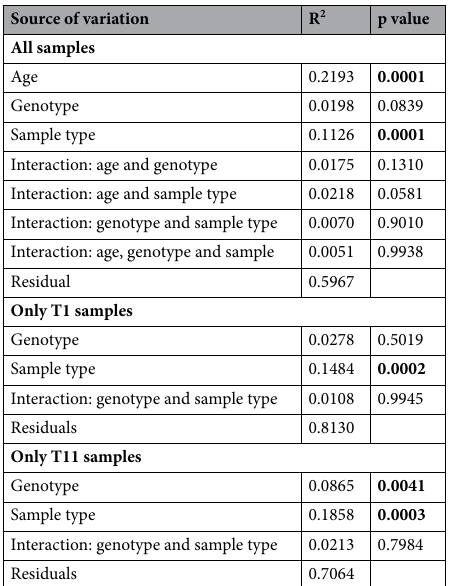
Table 1. Results of PERMANOVA analysis to test the effects of different sources of variation (age, genotype, and sample type) on the Bray–Curtis distance matrix between all pairs of samples (T1 and T11 together), between pairs of samples at T1 (young rats), or between pairs of samples at T11 (old rats). Statistically significant values (p < 0.05) are highlighted in bold.